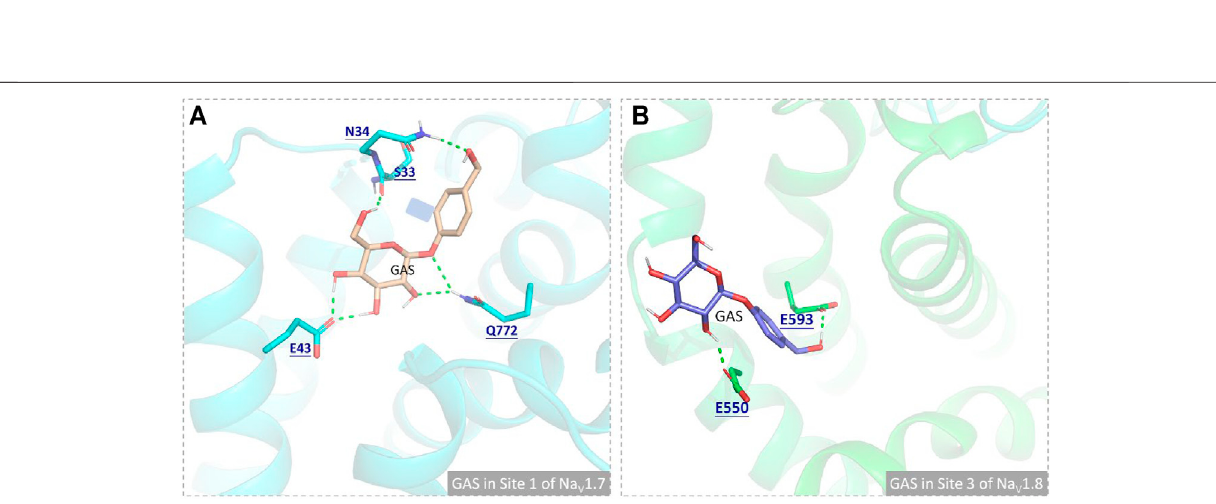
Frontiers in Pharmacology |